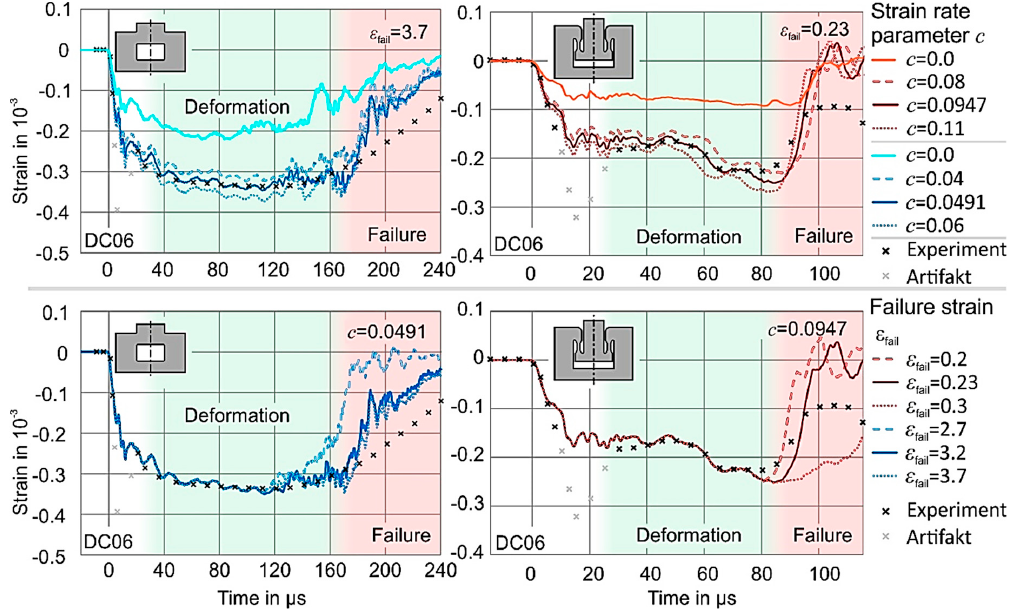
Figure 20. Sensitivity of the simulated strain-time curves at the measurement body of the electromagnetically accelerated test setup. Investigated material DC06 regarding the rate parameter c and the strain at failure at a nominal hammer speed of approximately 30